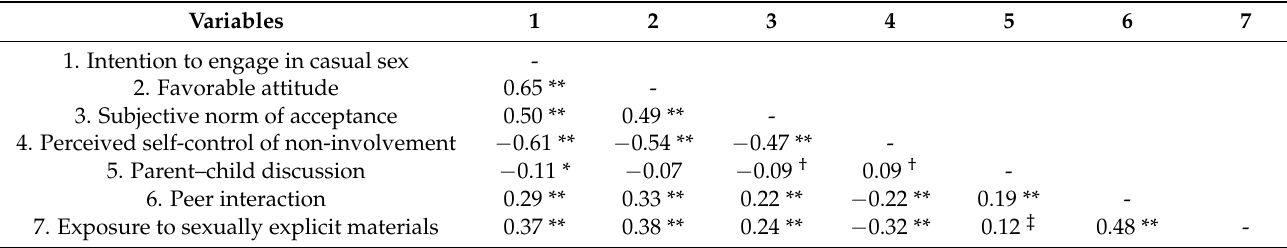
Table 2. Correlations between intention, three TPB constructs, parent–child discussion, peer interaction, and exposure to sexually explicit materials: Pearson’s correlation ( n =